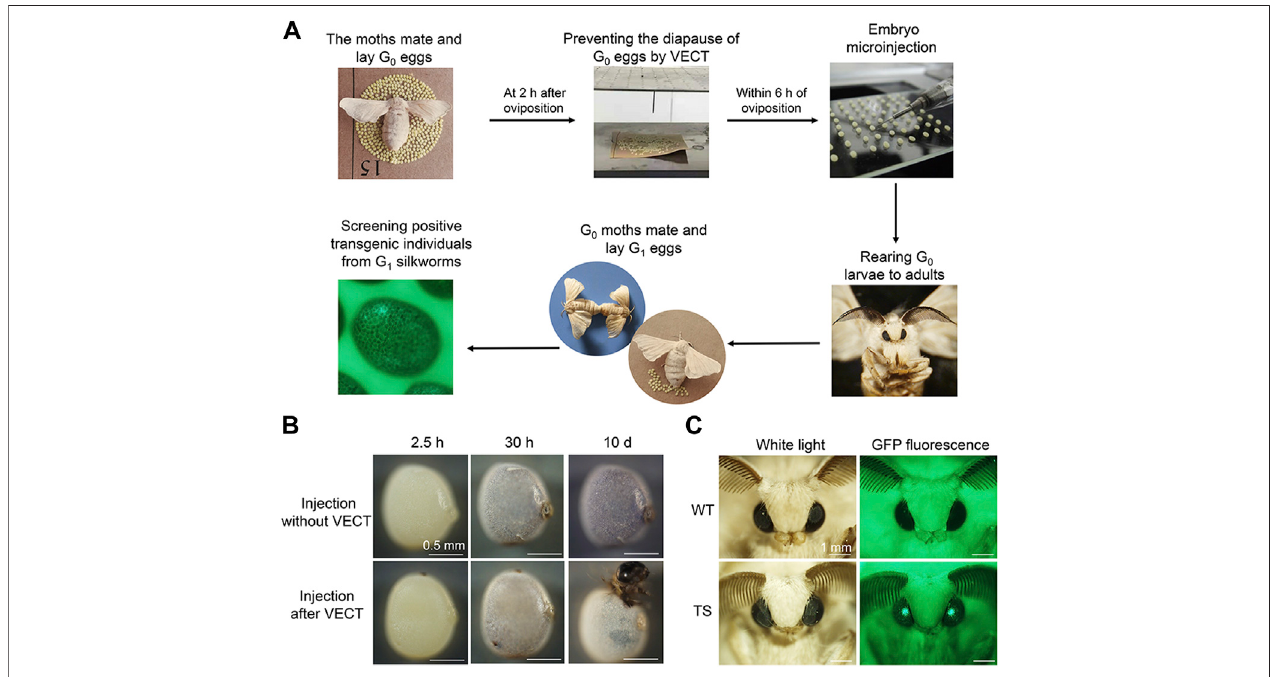
FIGURE 5 | Germline transformation of diapause silkworm strains based on the VECT strategy combined with pre-blastoderm microinjection. (A) Schematic diagramoftheexperimentalproceduresforgermlinetransformationofdiapausesilkwormstrains. (B) ImagesofthedevelopmentalstagesofG0DZeggswithoutorwith VECT after injection of piggyBac -derived vectors. (C) Expression ofthe EGFP gene in adult G1transgenic silkworms. Adults ofthe wild-type DZ(WT) and G1transgenic silkworms (TS) showing a white light, and GFP fl uorescence in the compound eye.